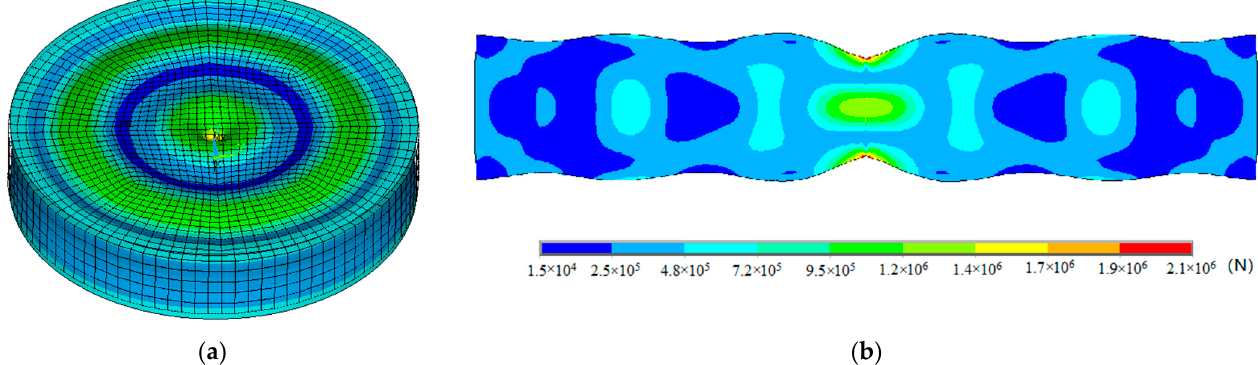
Figure 2. ( a ) Three-dimensional vibration picture at 212.5 kHz. ( b ) The side views of a full scale at 212.5 kHz.